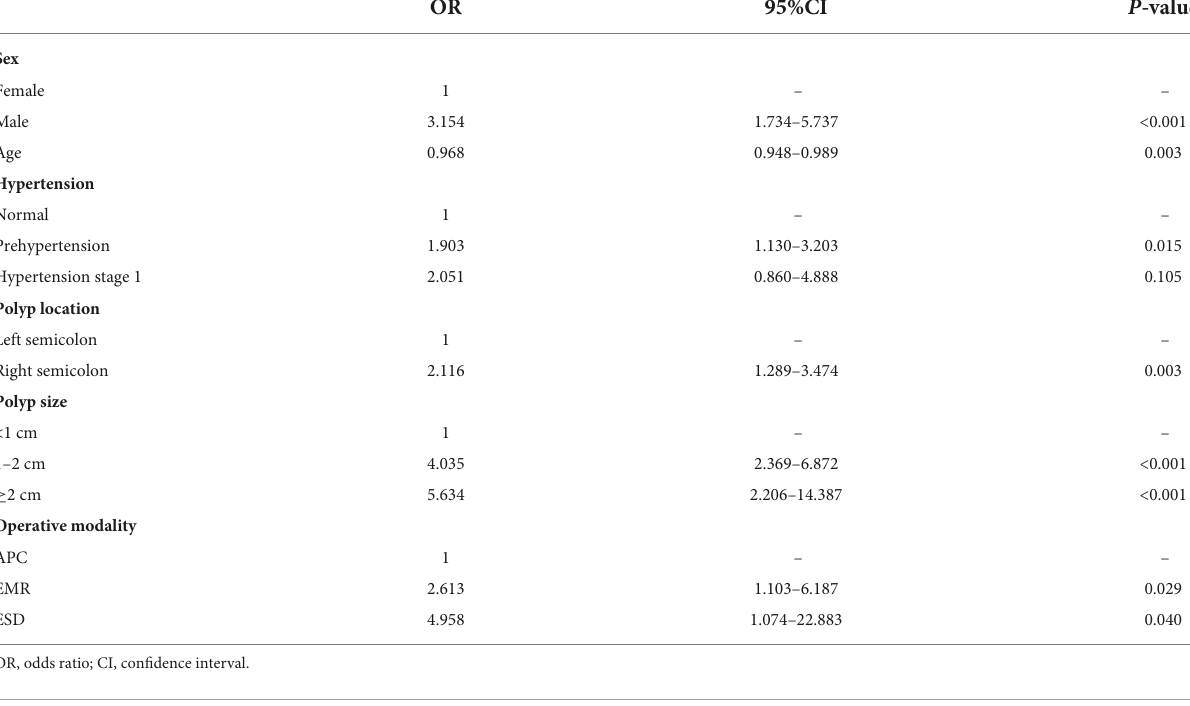
TABLE 4 Multiple logistic regression analysis for risk factors of delayed post-polypectomy bleeding.